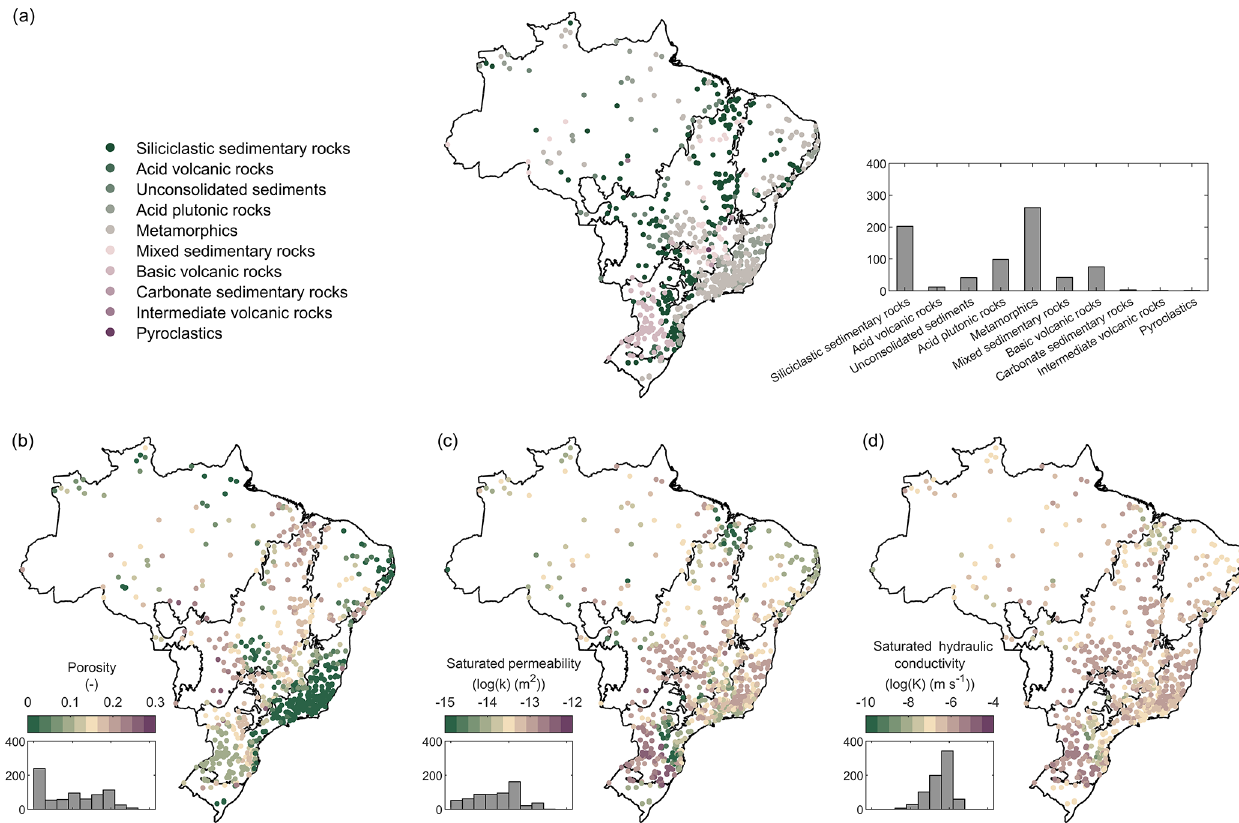
Figure 10. Spatial distribution of geology attributes of the CABra catchments. (a) Most common lithology class in the catchment; (b) porosity (dimensionless); (c) saturated permeability (in m 2 ); (d) saturated hydraulic conductivity (in ms − 1